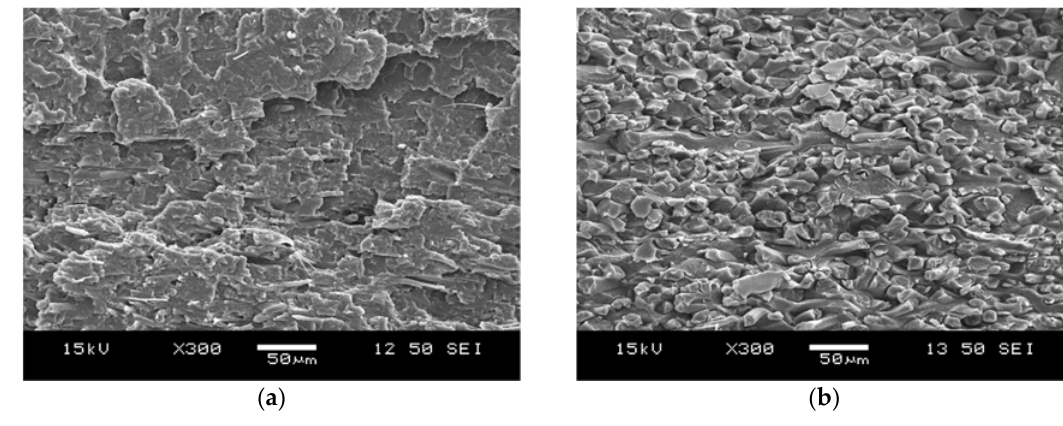
Figure 9. SEM images of self ‐ reinforcement (SR)–PLA composites made from non ‐ annealed ( a ) and annealed ( b ) fibres with 0.5% D ‐ lactide content (3100HP). Magnification: 300×.